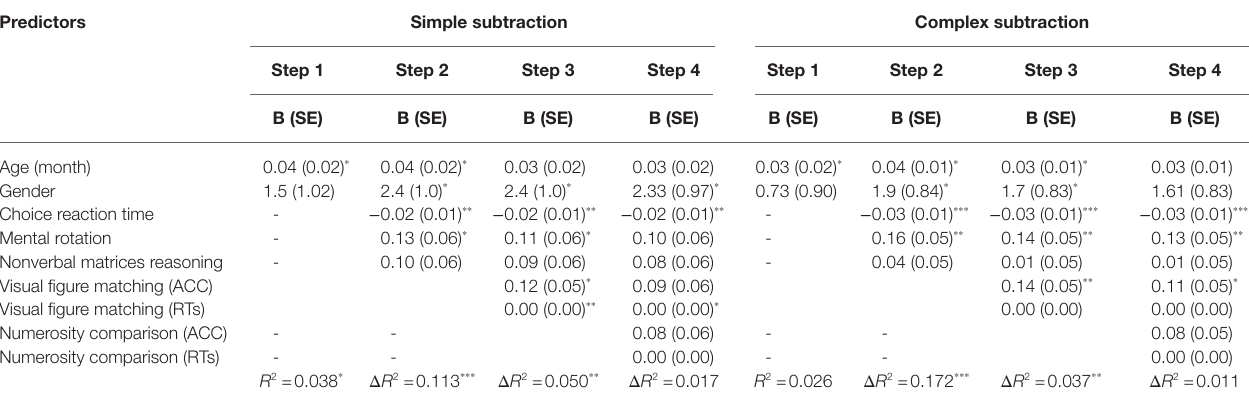
TABLE 4 | Results from hierarchical regression analyses for the relations of numerosity processing and arithmetic computation (simple subtraction and complex subtraction) after controlling for age/gender (step 1), general cognitive processes (step 2) and figure matching (step